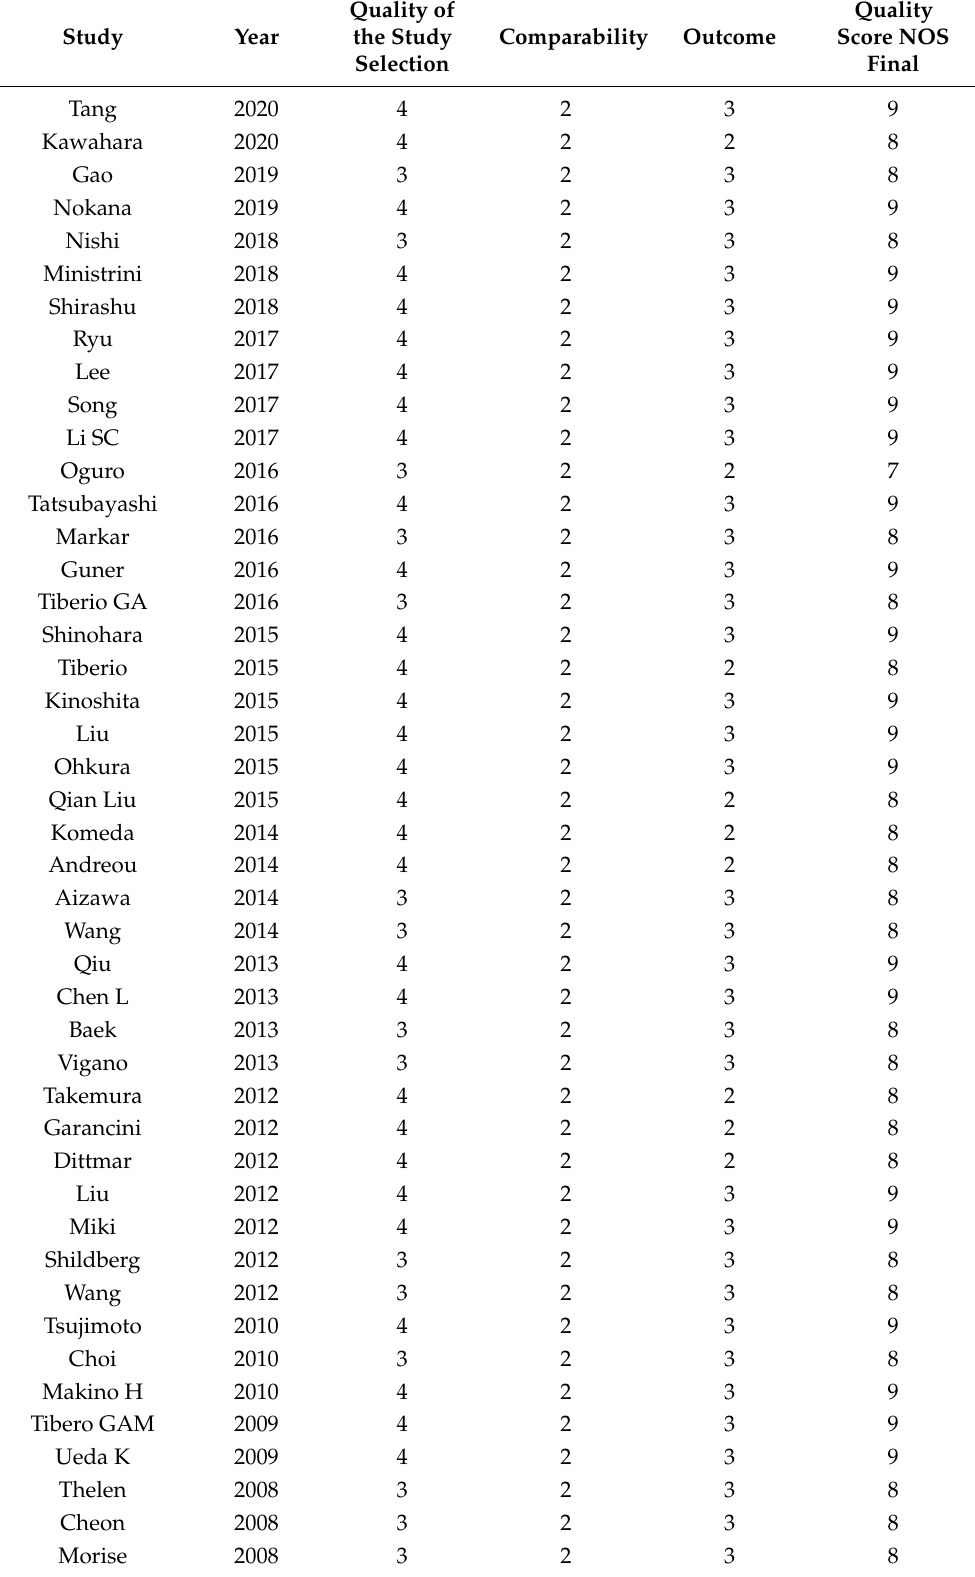
Table 3. Study quality rating via the Newcastle–Ottawa scale [36]. Study Year